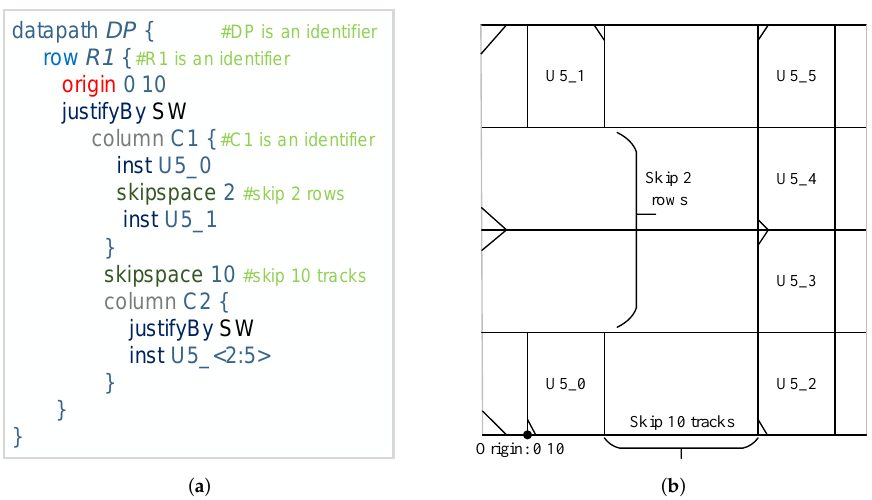
Figure 5. Relative Placement File and its Corresponding Placement. ( a ) Relative Placement File; ( b ) Placement of